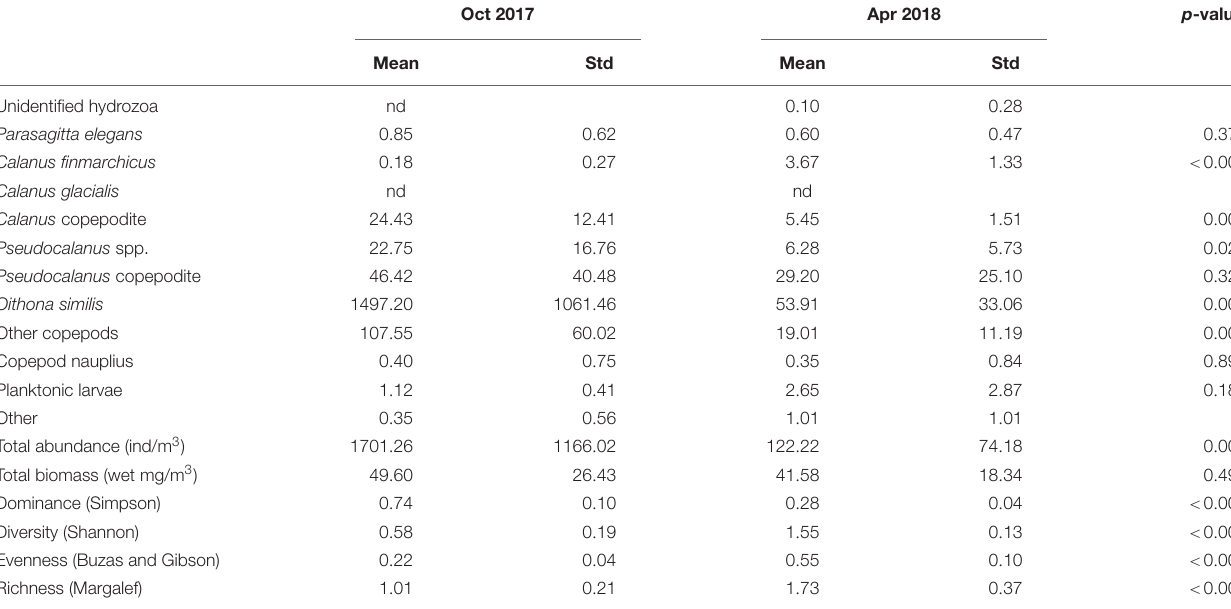
TABLE 2 | Mean abundance, biomass, and ecological parameters for zooplankton collected in October 2017 and April 2018.